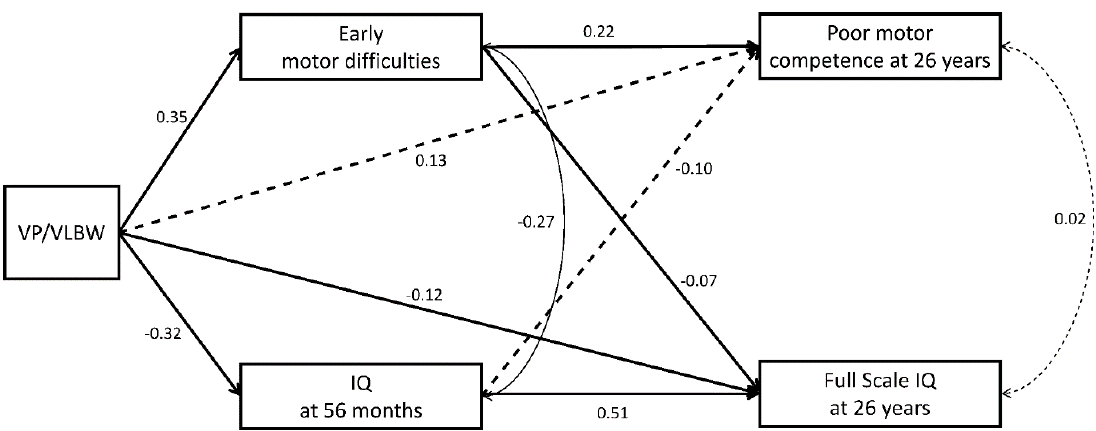
E ff ects of VP / VLBW Birth and Early Motor Di ffi culties on Motor and Cognitive Outcomes in Adulthood